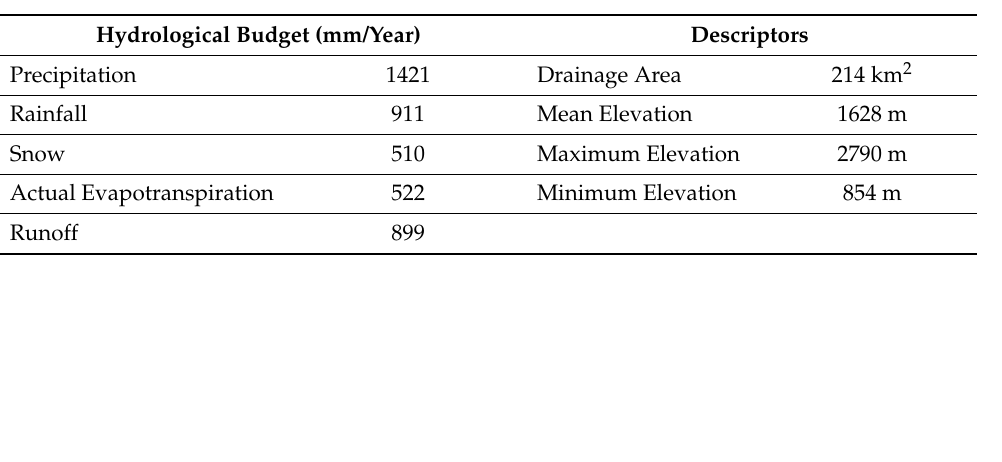
Table 1. General descriptive information of the watershed (average values over the period